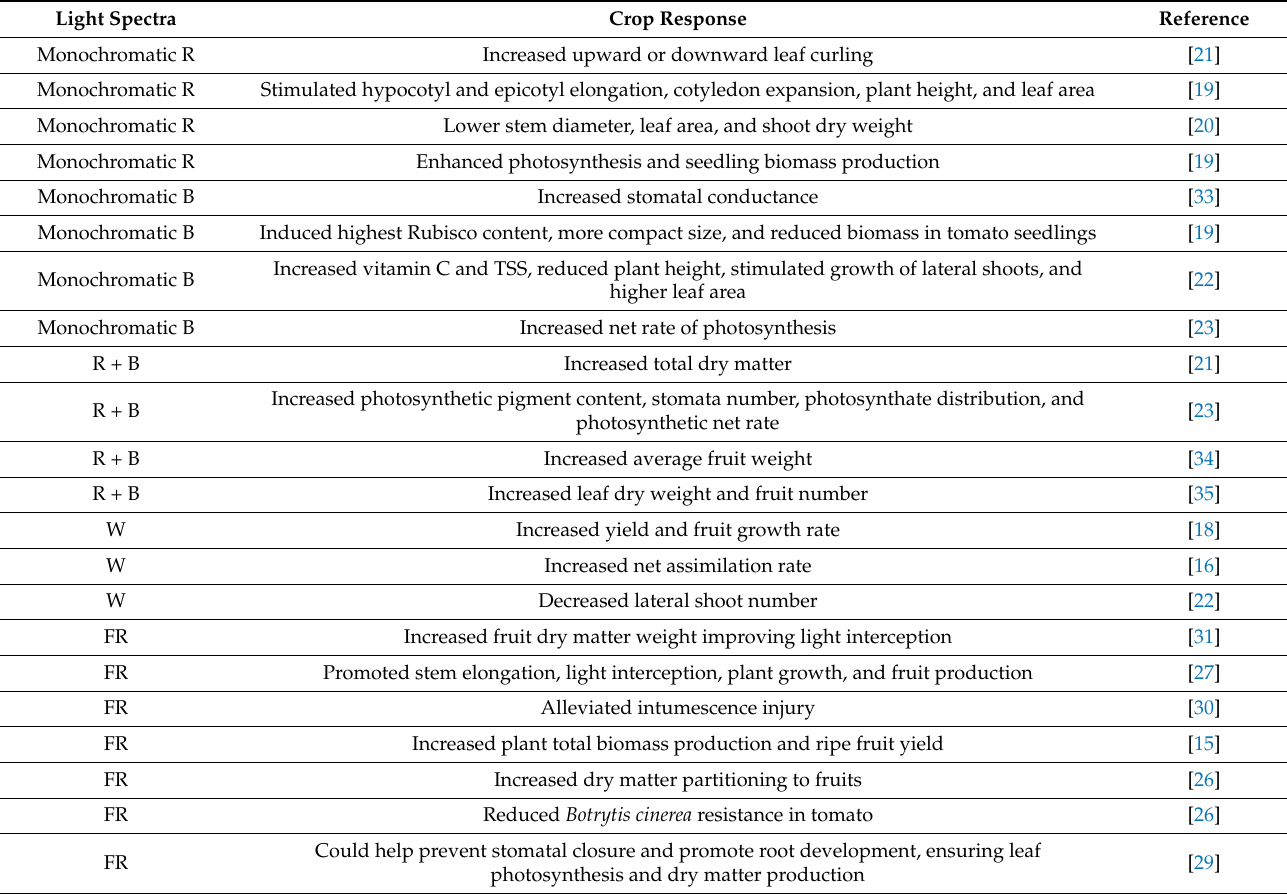
Table 4. Relationship between light spectra and crop